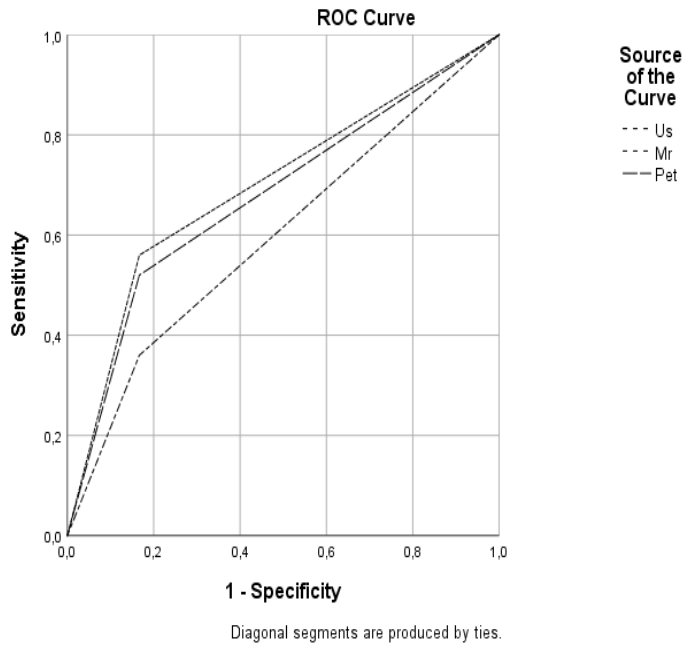
Figure 2. Receiver operating characteristic analysis curves of the US, MRI, and F18-FDG-PET/CT.